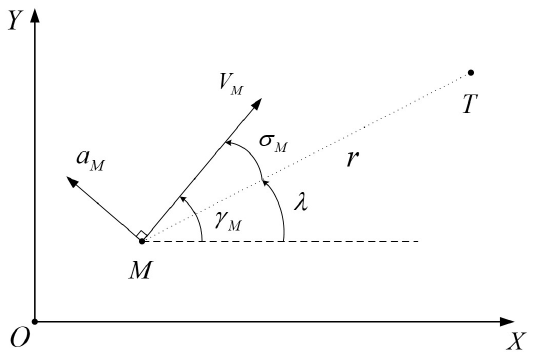
Figure 1. Two-dimensional engagement geometry for a stationary